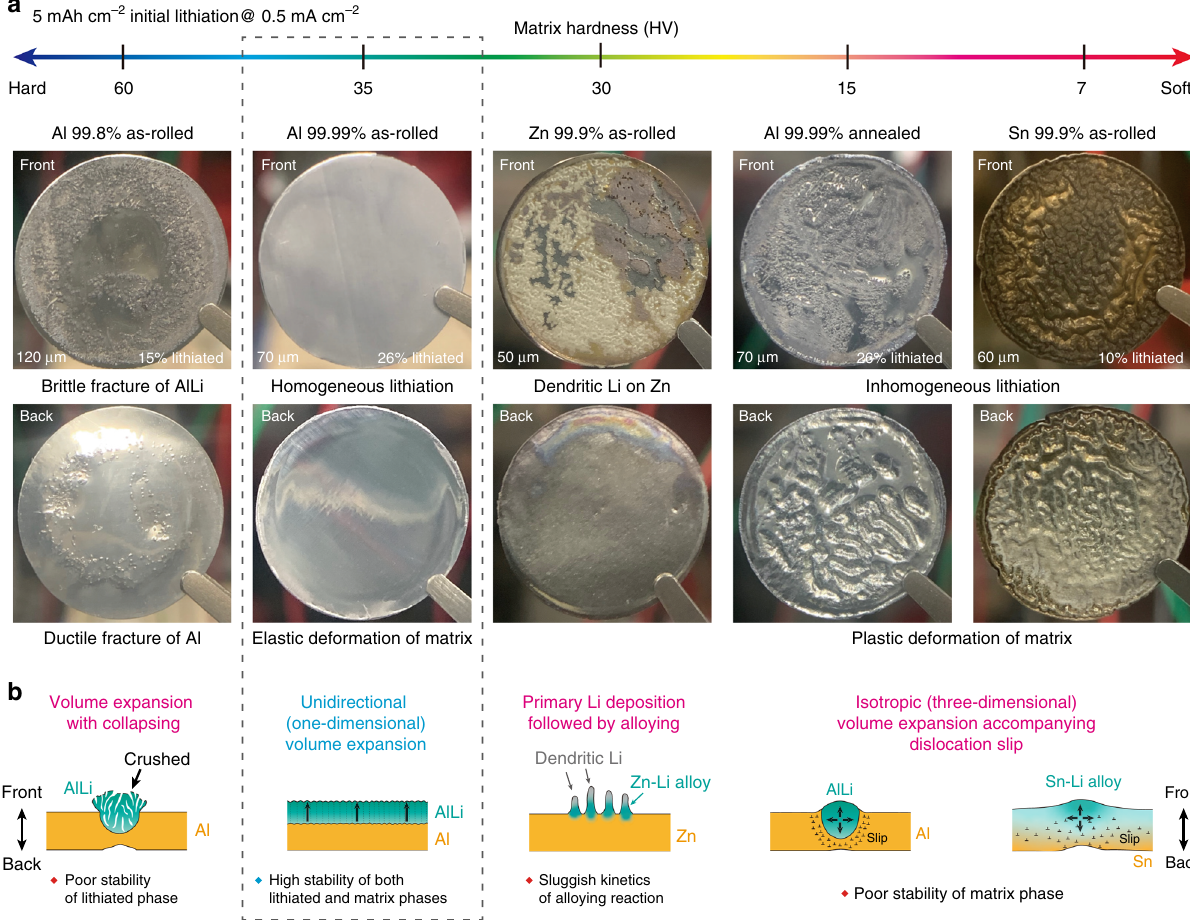
Fig. 1 Structural stability of various metallic foils after initial lithiation. a Photographs of various metallic foils after lithiation of 5 mAh cm − 2 . Average Vickers hardness (HV) of each foil is given in the upper graph. The lithiation was conducted at a current density of 0.5 mA cm − 2 with a Li metal counter- electrode. The original thickness and lithiation percentage of each foil are also denoted in the front-side photo. The percentage fi gure of lithiation in each sample is displayed based on the total capacity of each anode depending on the foil thickness. As to Zn, the percentage is not presented, because Li metal is mainly deposited on the surface instead of the formation of Li-Zn alloy; see also Supplementary Fig. 1c. The as-rolled Al (99.99%) foil shows a homogeneous lithiation on the front side and a suf fi ciently retained stable Al matrix on the back side. b Schematic illustrations of lithiation process reasonably inferred from SEM pictures obtained for respective foils; see Supplementary Fig.